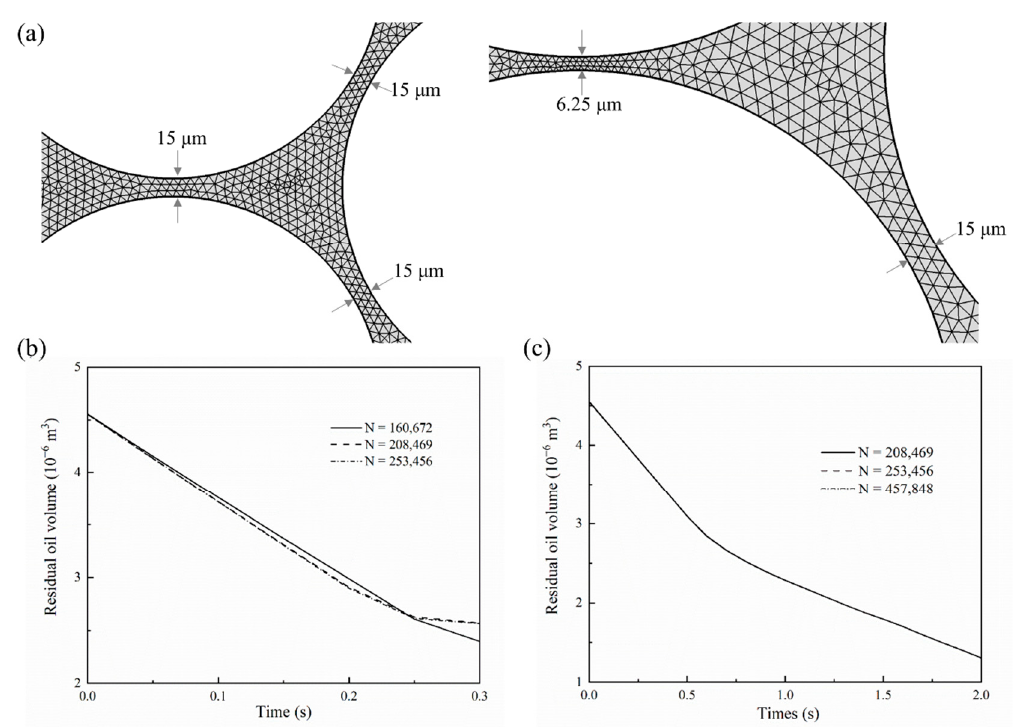
Figure 3. ( a ) Finite element mesh used in numerical simulations, ( b ) mesh independence tests for immiscible and near- miscible flooding models, and ( c ) mesh independence tests for miscible flooding model.